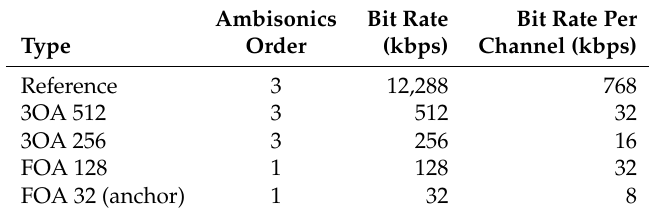
Table 3. Encoding/compression schemes used with single point audio